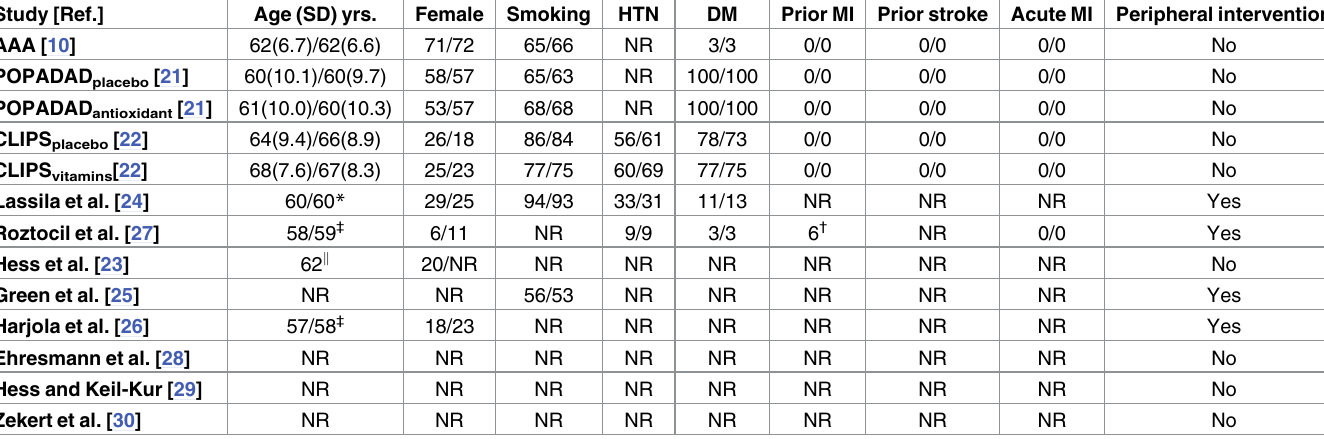
Table 2. Baseline characteristics of the individuals enrolled in each trial. Study